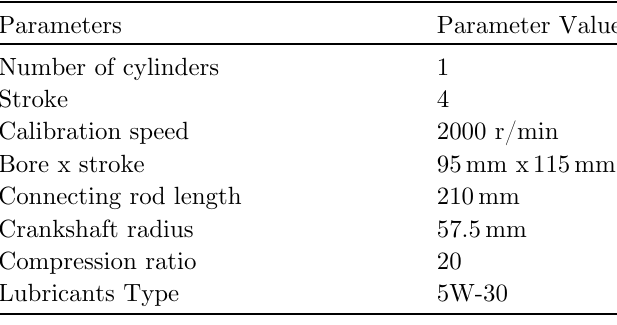
Table 1. Main engine parameters.